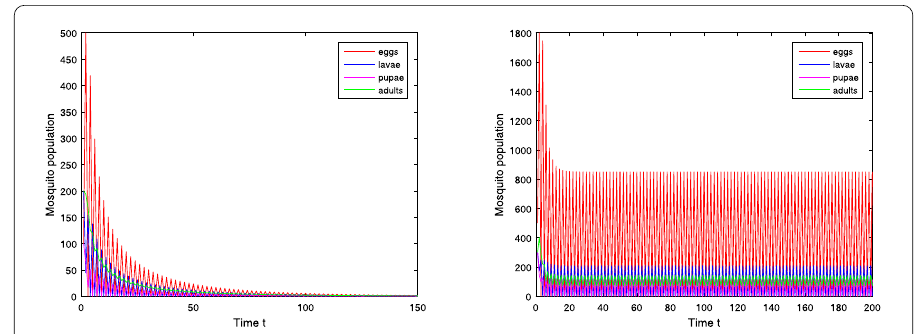
Figure 2 The function forms and some parameters are given in Fig. 1. When the breeding of the mosquito population is seasonal with 2-cycle, b (2 t ) = (cid:6) b , b (2 t + 1) = 0. As (cid:6) b = 2.5, the inherent net reproductive number (cid:6) E (cid:6) (cid:2) 0 = 0.8333 < 1, 0 is globally asymptotically stable. Solutions approach